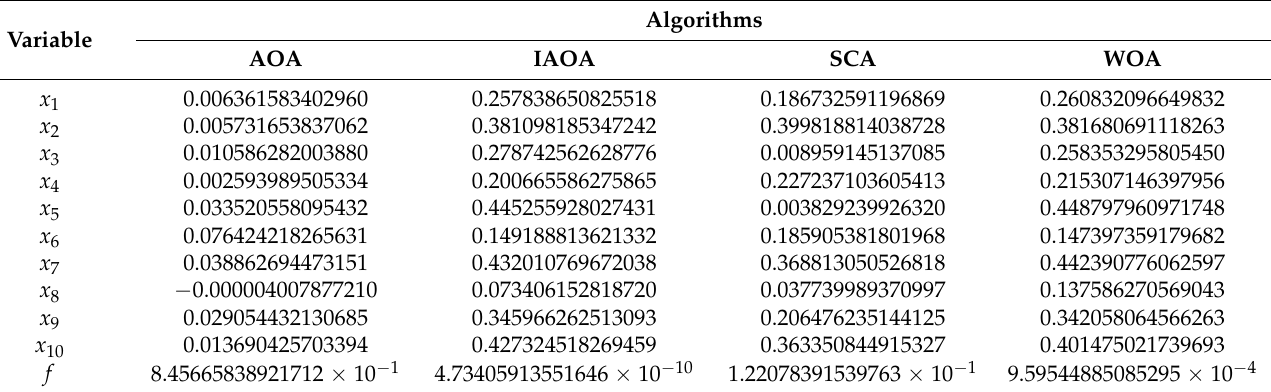
Table 1. Comparison of the experimental results for